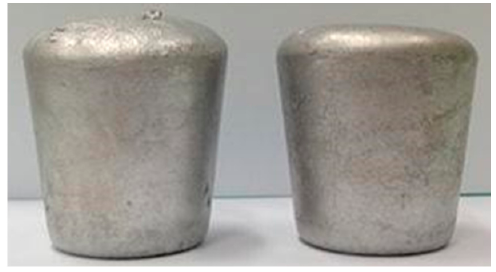
Figure 3. A356 / SiC feedstock.